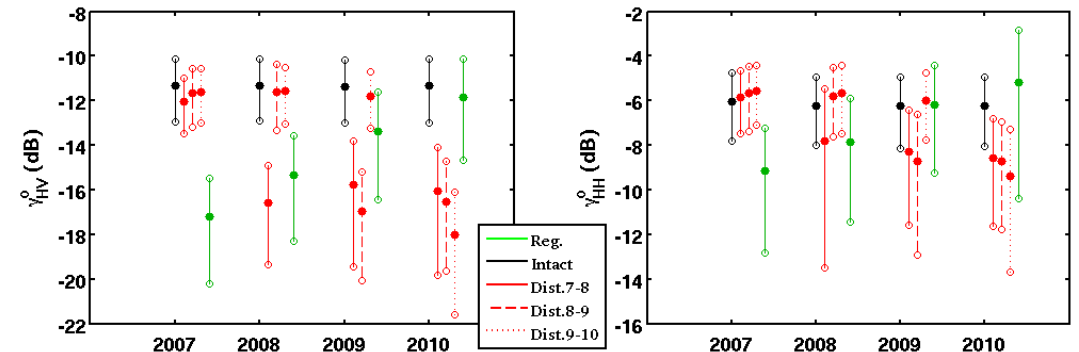
Figure 2. PALSAR multi-temporal γ HV and γ HH for intact forest, disturbed areas between 2007 and 2008 (Dist.7–8), 2008 and 2009 (Dist.8–9) and 2009 and 2010 (Dist.9–10) and regrowth areas between 2007 and 2010 (Reg.), calculated using the database described in Section 2.3. The average (filled point) and standard deviation (vertical bar) are shown.